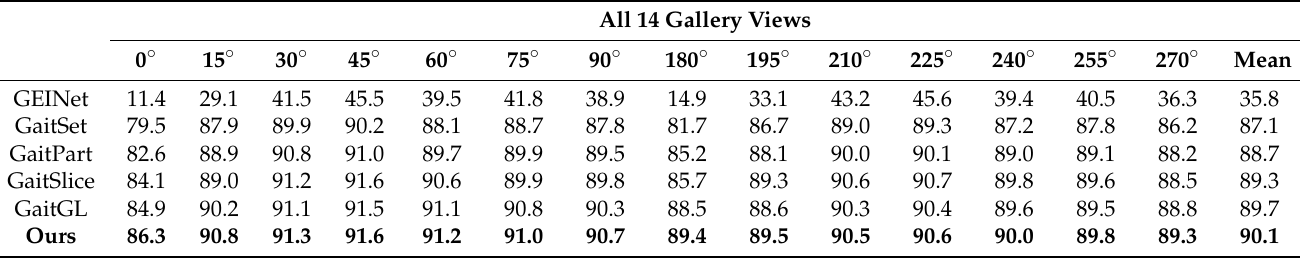
Table 5. Averaged rank-1 accuracies on OU-MVLP, excluding identical-view cases. All 14 Gallery Views